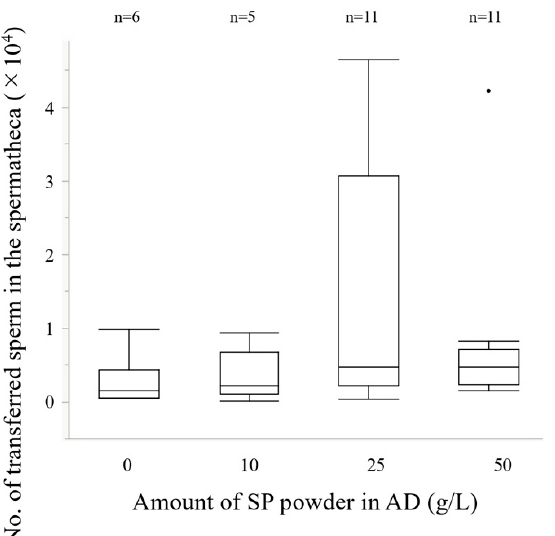
Figure 7. Relationship between the amount of sweet potato powder and the number of sperm in testes-seminal vesicles complexes. Boxplots represent medians (thick lines), the first and third quar- tile ranges (box perimeters), minimum and maximum (whiskers). The diet of the larvae significantly affected the number of sperm in the testes-seminal vesicles complex (GLM; L-R χ 2 = 11.81, p < 0.01). Different letters show significant differences ( p < 0.05).